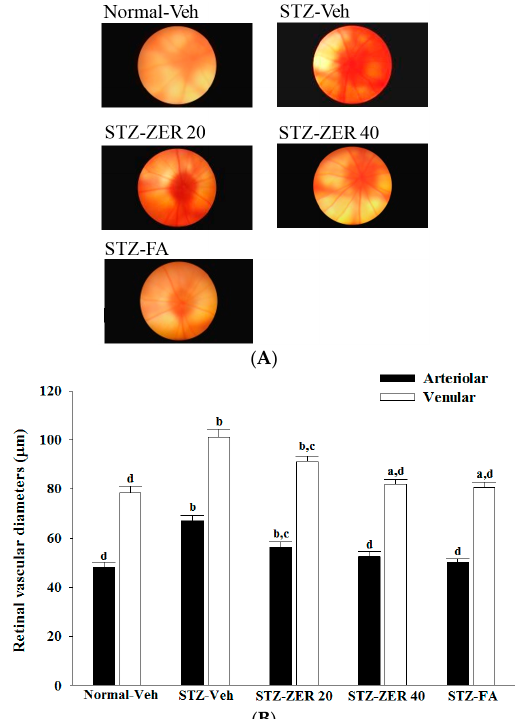
Figure 2. Fundus photographs ( A ) and changes in retinal vascular diameters ( B ) in normal or STZ-diabetic rats receiving three months of treatment. STZ-diabetic rats were administered 20 mg/kg/day zerumbone (STZ-ZER 20), 40 mg/kg/day zerumbone (STZ-ZER 40) or 100 mg/kg fenofibric acid (STZ-FA) by oral gavage once daily for three months. Another group of STZ-diabetic rats (STZ-Veh) and normal rats (Normal-Veh) were administered the same volume of vehicle used to prepare the test medication solutions. Data are mean ± SD from eight rats per group. a p < 0.05 and b p < 0.01 compared to vehicle-treated normal rats, respectively; c p < 0.05 and d p < 0.01 compared to the values of vehicle-treated STZ-diabetic rats,